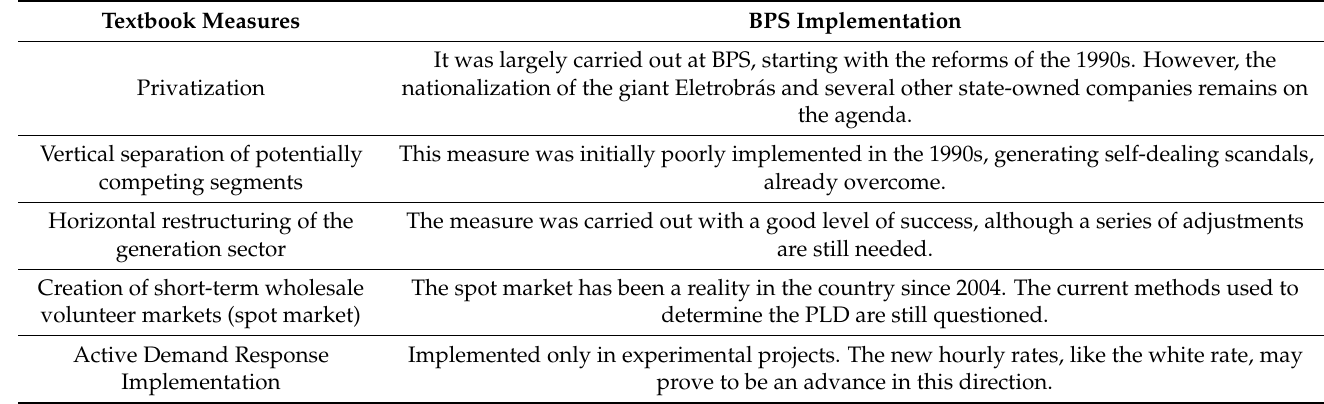
Table 1. Textbook measures of the electric sector reforms and their applications in the BPS [41]. Textbook Measures BPS